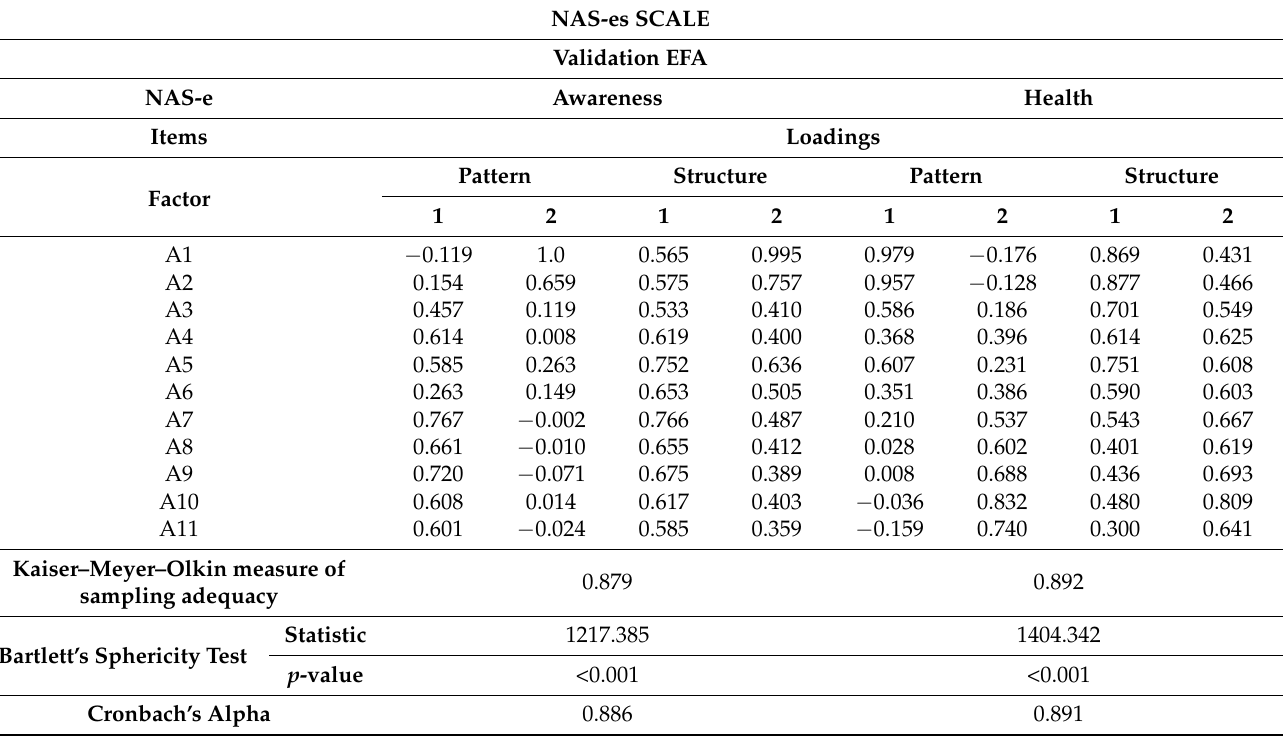
Table 2. Factor loadings and Cronbach’s alphas for the Nurse Awareness Scale (NAS-es) of the questionary NEAT-es 1st version EFA (n = 251 participants).